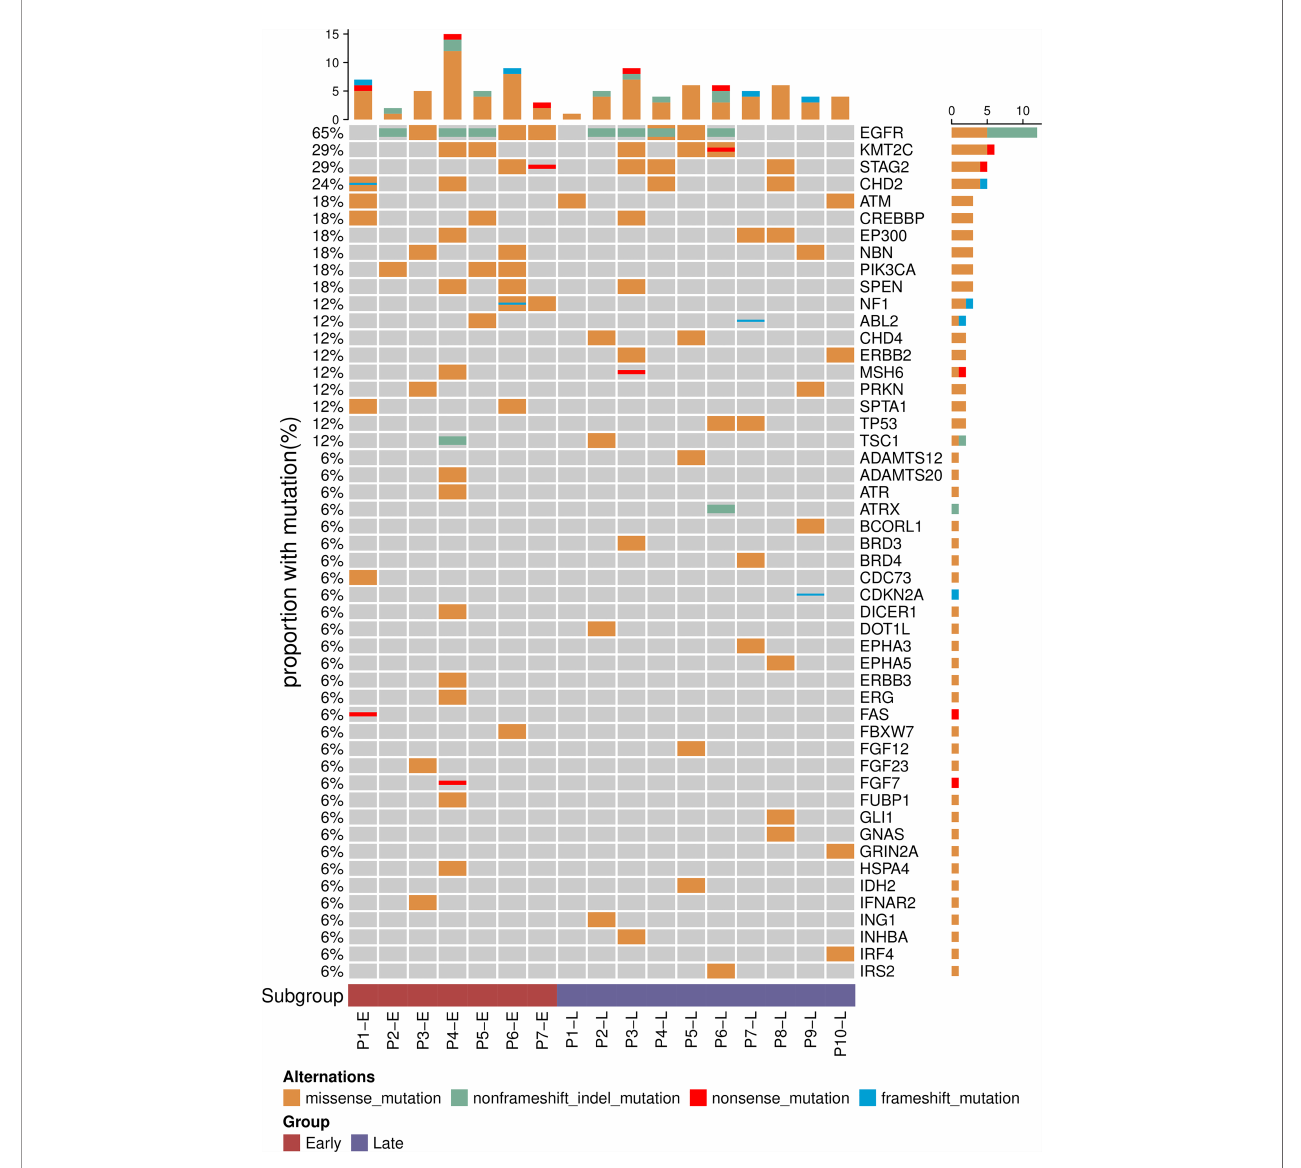
FIGURE 1 | Mutational pro fi les of early- and late-stage LUAD. Top 50 genes with the highest mutation frequency among the 17 patients. The frequency of each gene mutated in the cohort is displayed on the